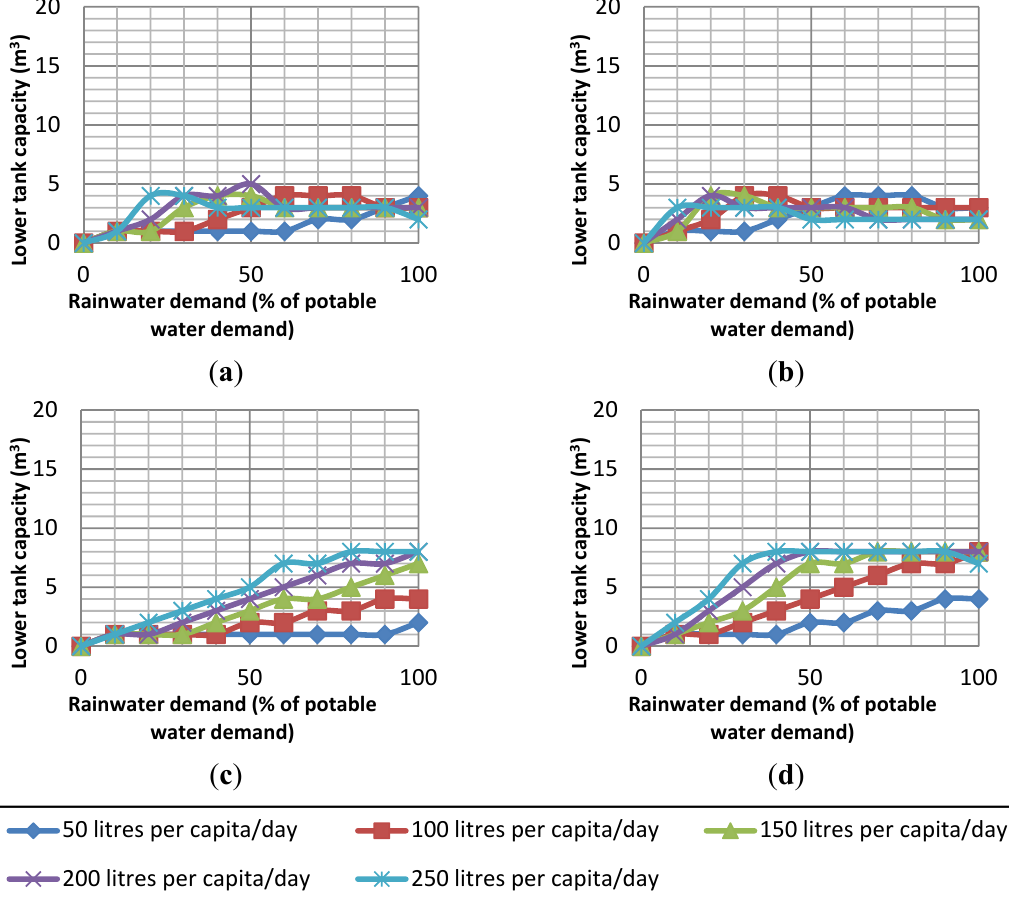
Figure 14. Rainwater tank capacity as a function of rainwater demand, catchment surface area, and number of people per house in Berlin, Germany. ( a ) 100 m 2 and two